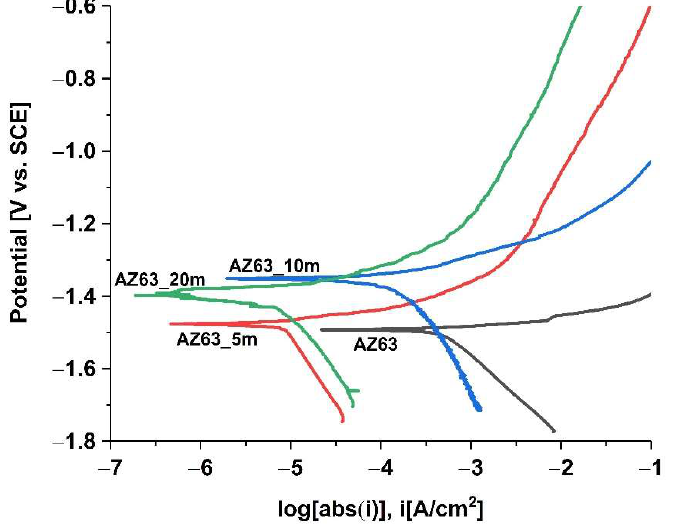
Figure 11. Polarization curves for AZ63 magnesium alloy in 3.5% NaCl: AZ63 alloy, 5 min PEO